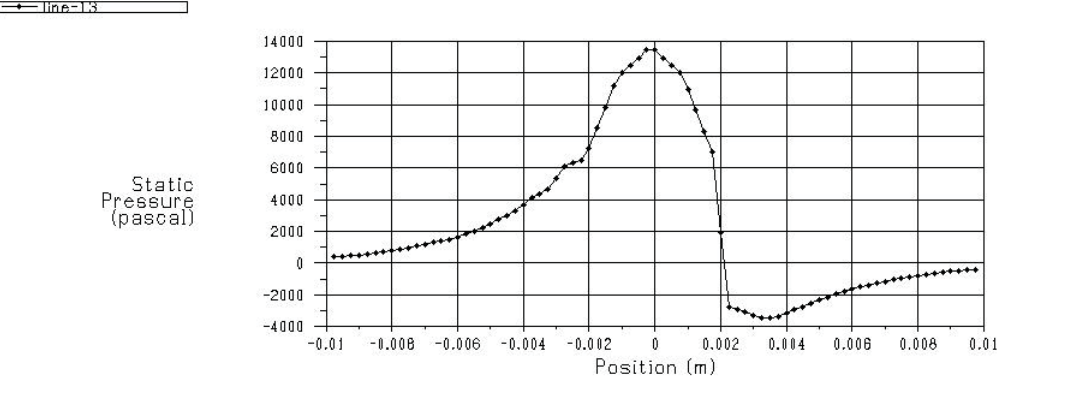
Figure 4: Pressure profile between the